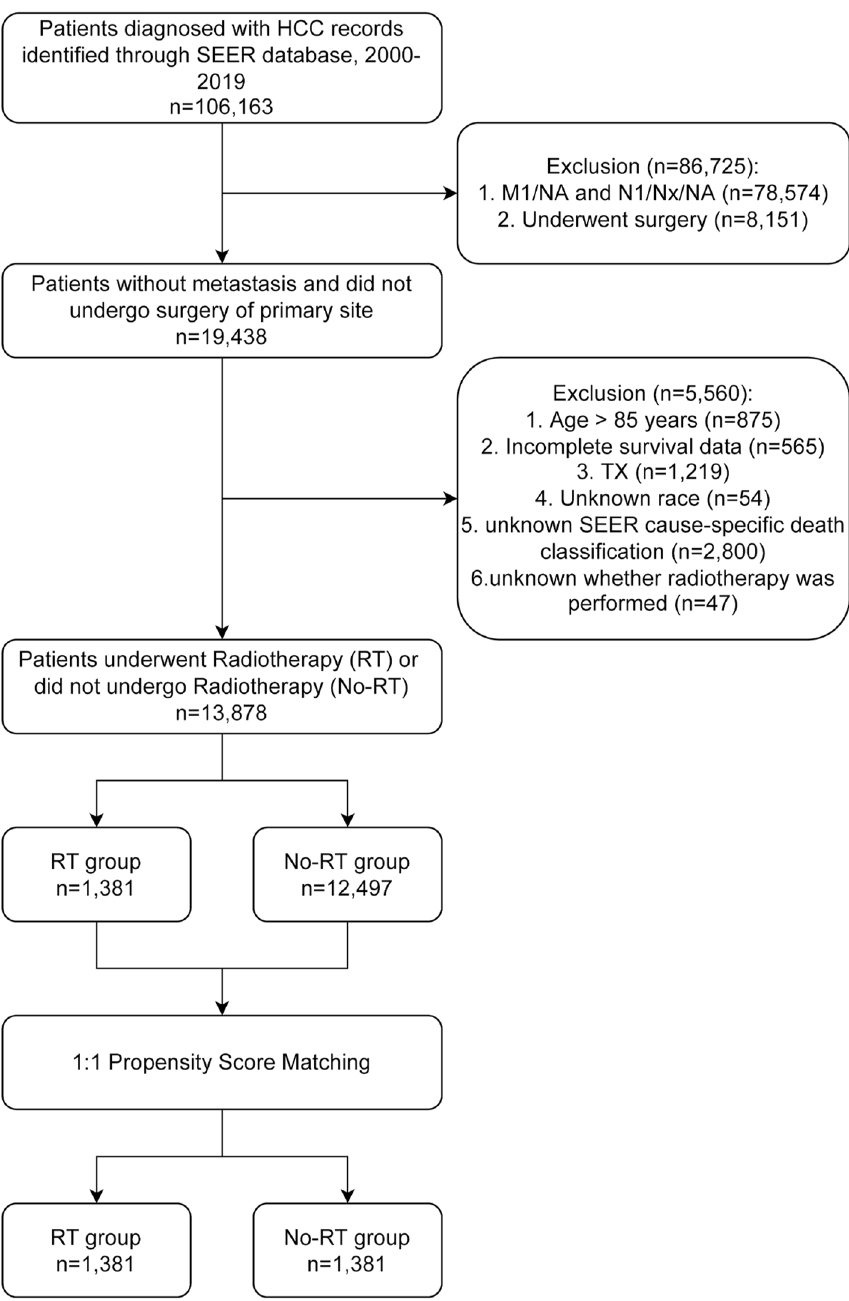
Figure 1. Flow chart depicting the patient selection process. RT